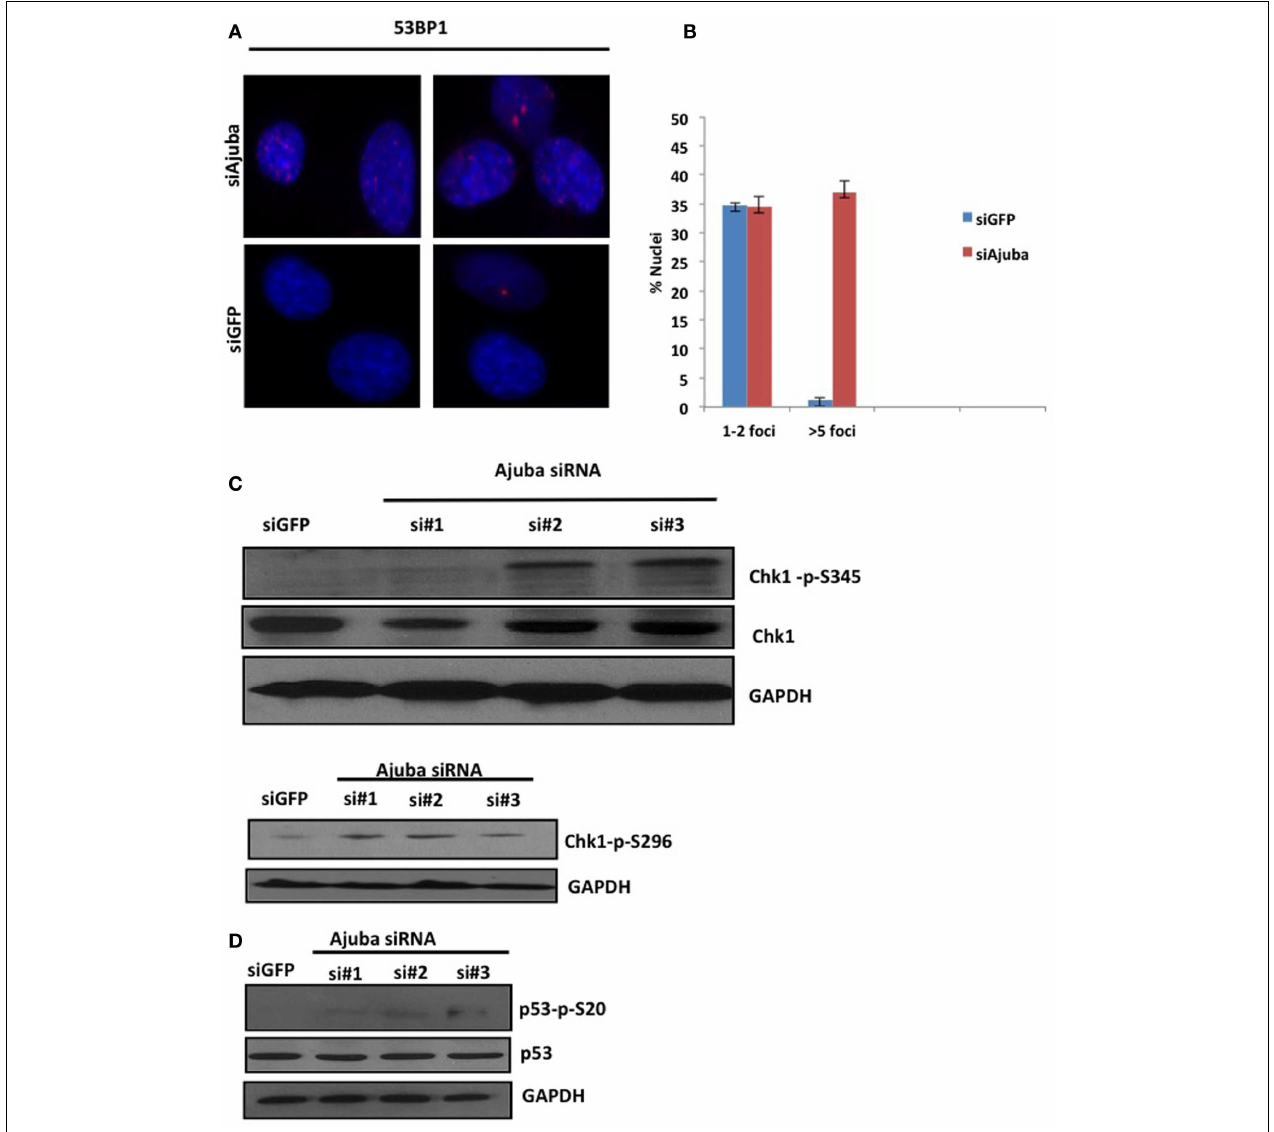
FIGURE 3 | Depletion ofAjuba results in activation of the DNA damage response . (A) Staining for p53BP1 foci on cells fixed 72h after transfection with siRNA #3, and siGFP as a negative control. Quantification of the number of p53BP1 foci on three independent siRNA experiments shown in (B) . ( C, D )Western blots for induction of Chk1 phosphorylation and induction of p53 phosphorylation, showed for the three target sites, 72 h after siRNA